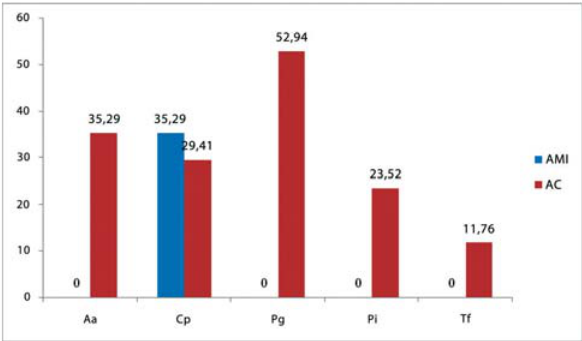
Fig. 6 - Análise das amostras arteriais infectadas por microorganismos (grupo PCS). Grupo PCS = Periodontite crônica grave; AMI = Artéria mamária interna; AC = Artéria coronária; Aa = Aggregatibacter actinomycetemcomitans; Cp = Chlamydia pneumoniae; Pg = Porphyromonas gingivalis; Pi = Prevotella intermedia; Tf = Tannerella